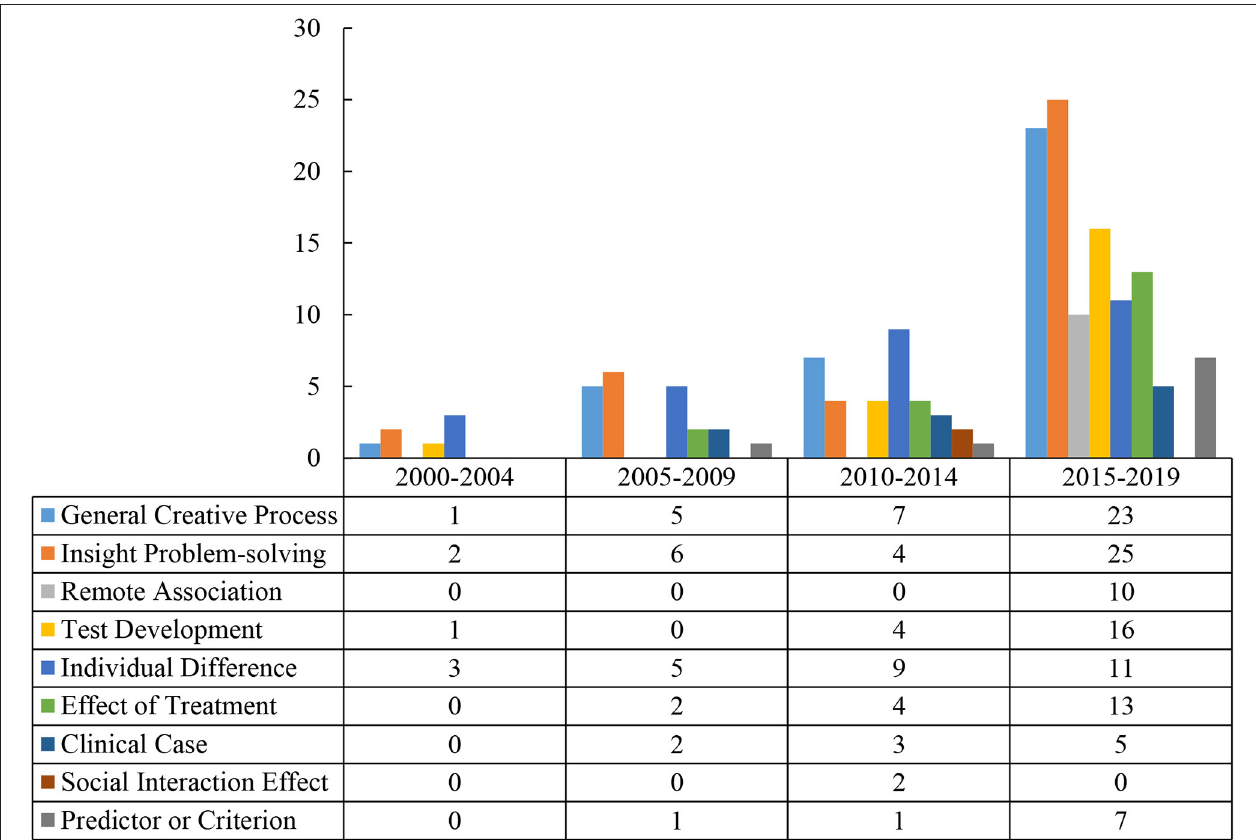
FIGURE 5 | Number of studies in each creativity-related research category every 5 years from 2000 to